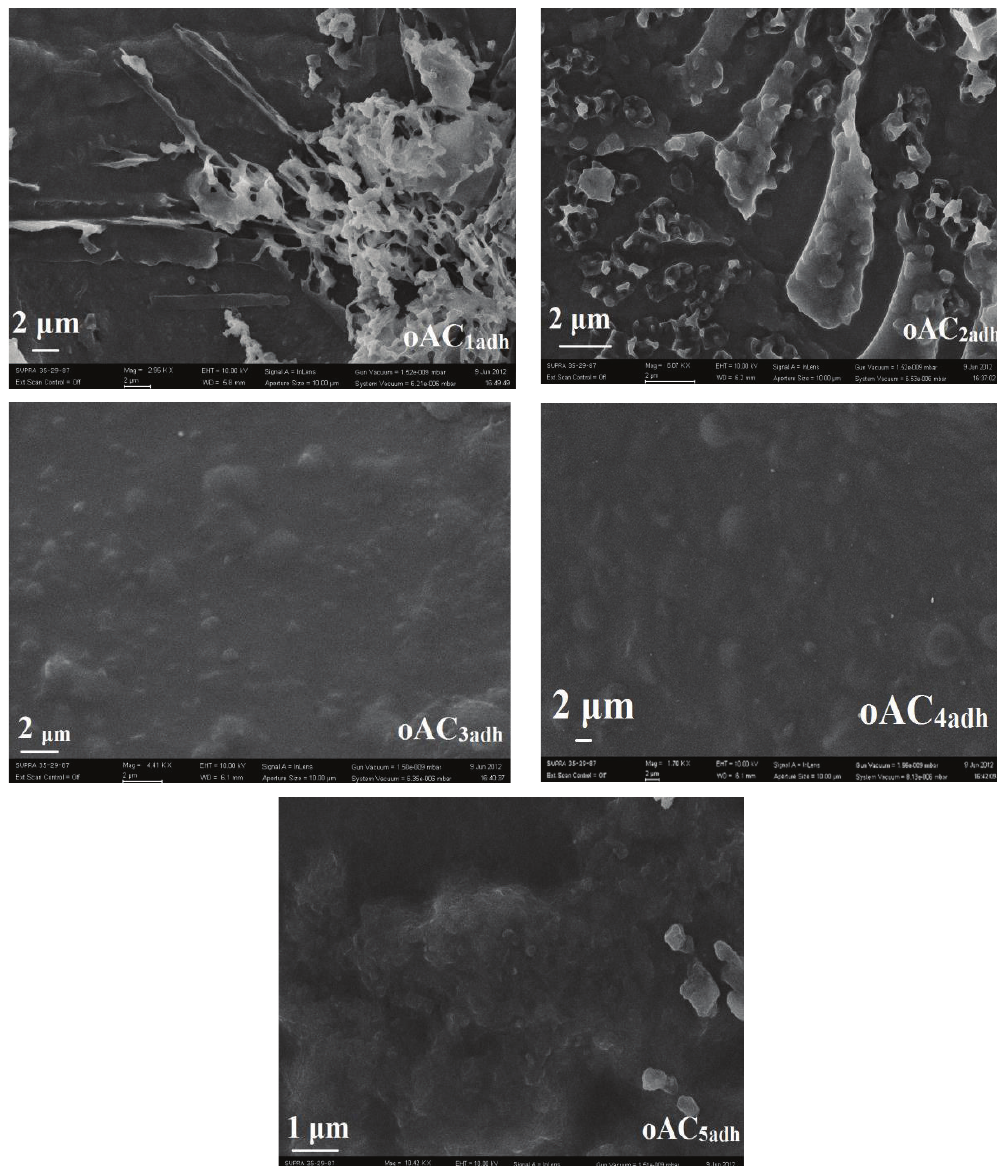
Figure 3: The SEM images of chemically cross-linked with adipic dihydrazide alginate/k-carrageenan hydrogel films (oAC 1adh –oAC 5adh